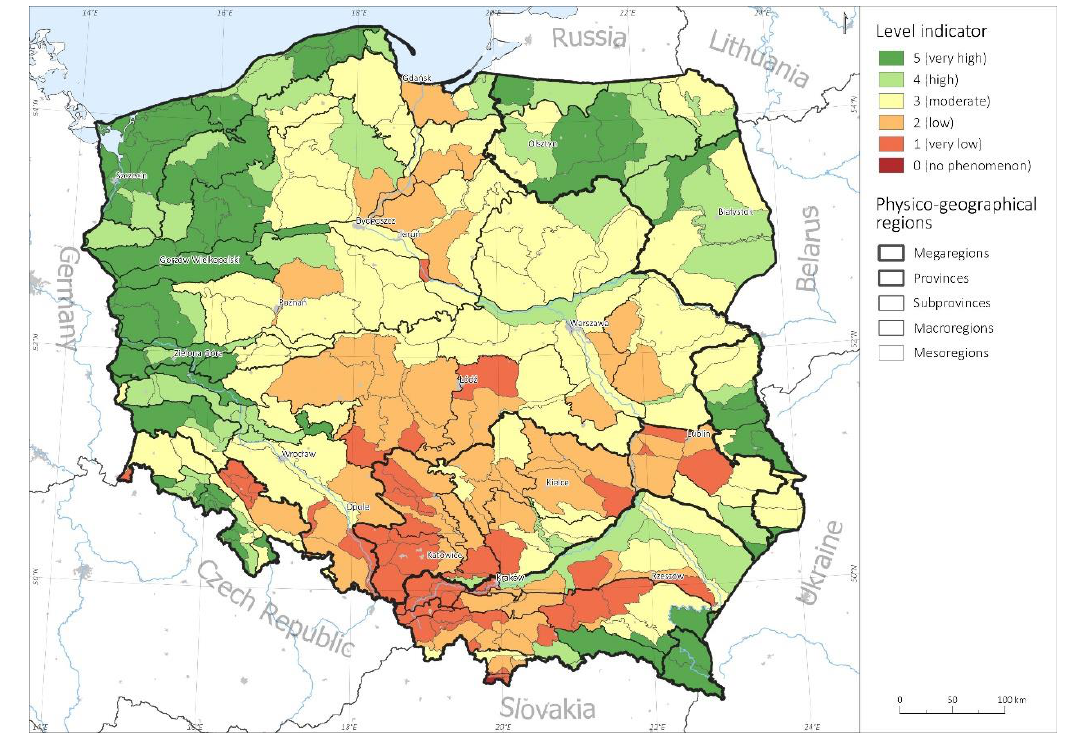
Figure 17. Synthetic evaluation index of EU support for nature value habitat protection on farms in Poland (Source: Authors based on ARMA and Statistics Poland data).